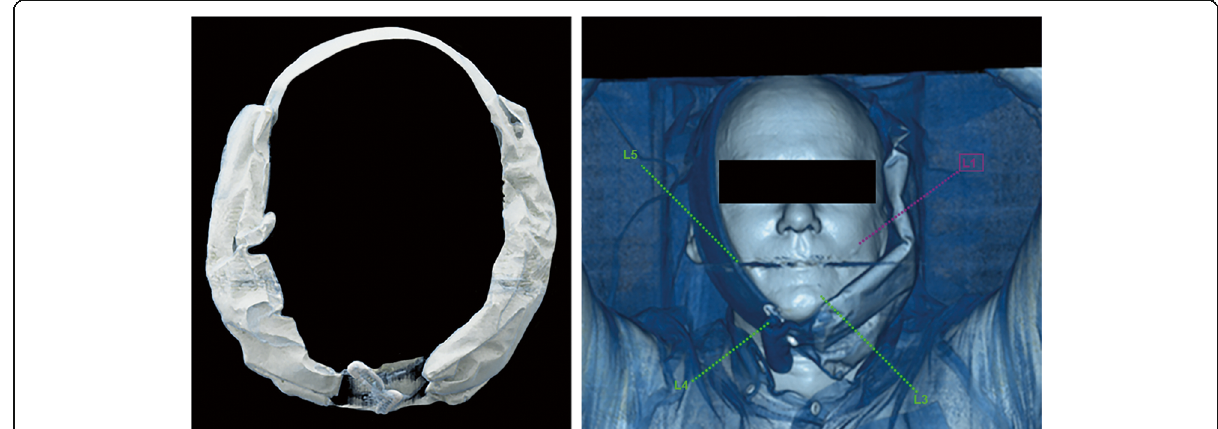
Fig. 1 The cooling device as used in this study (left); a patient scanned with a unilateral (left-sided) icepack